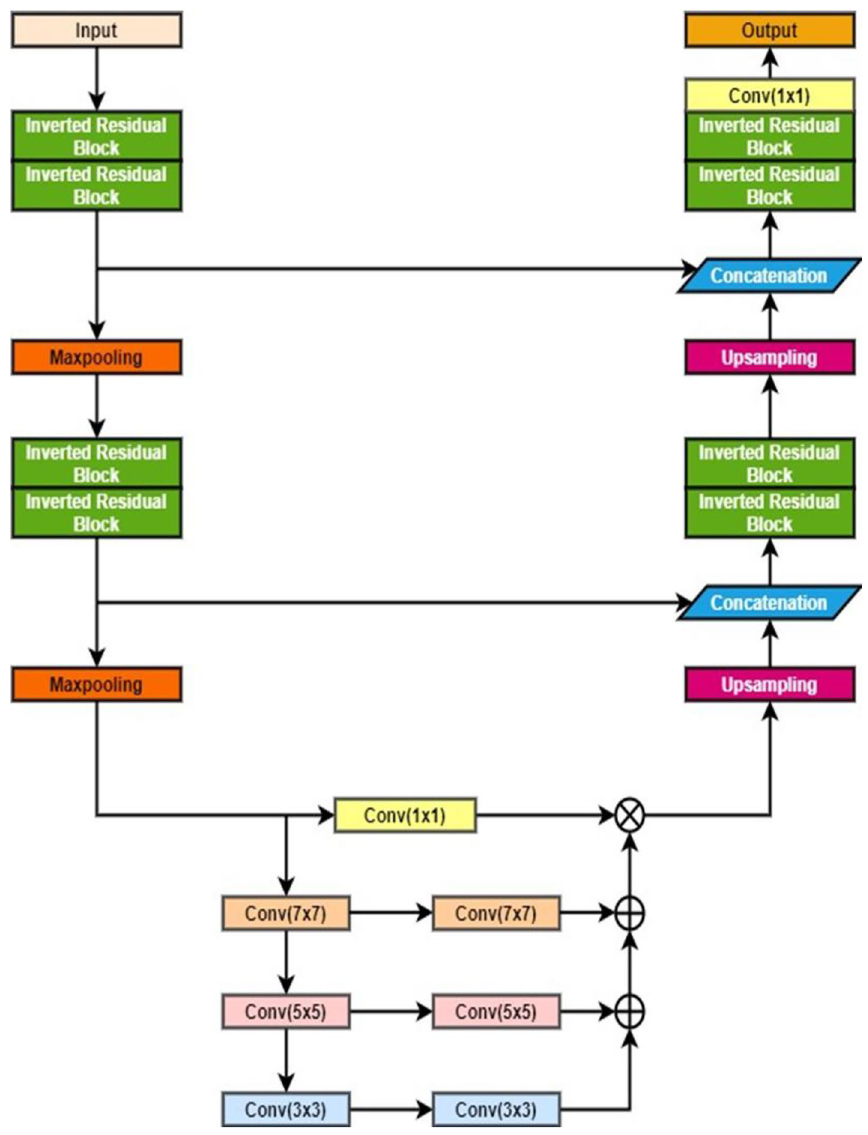
Figure 2. Architecture of Lung_PAYNet.